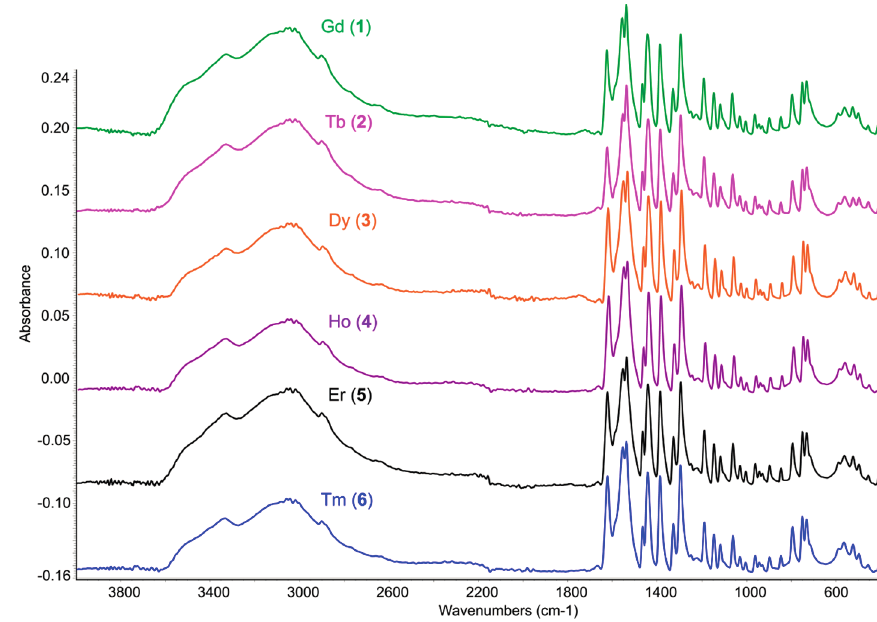
Figure 4. The overview of FT-IR spectra of K[Ln(salgly) 2 (H 2 O) 2 ] · H 2 O ( 1 – 6 ), where Ln represents Gd, Tb, Dy, Ho, Er and